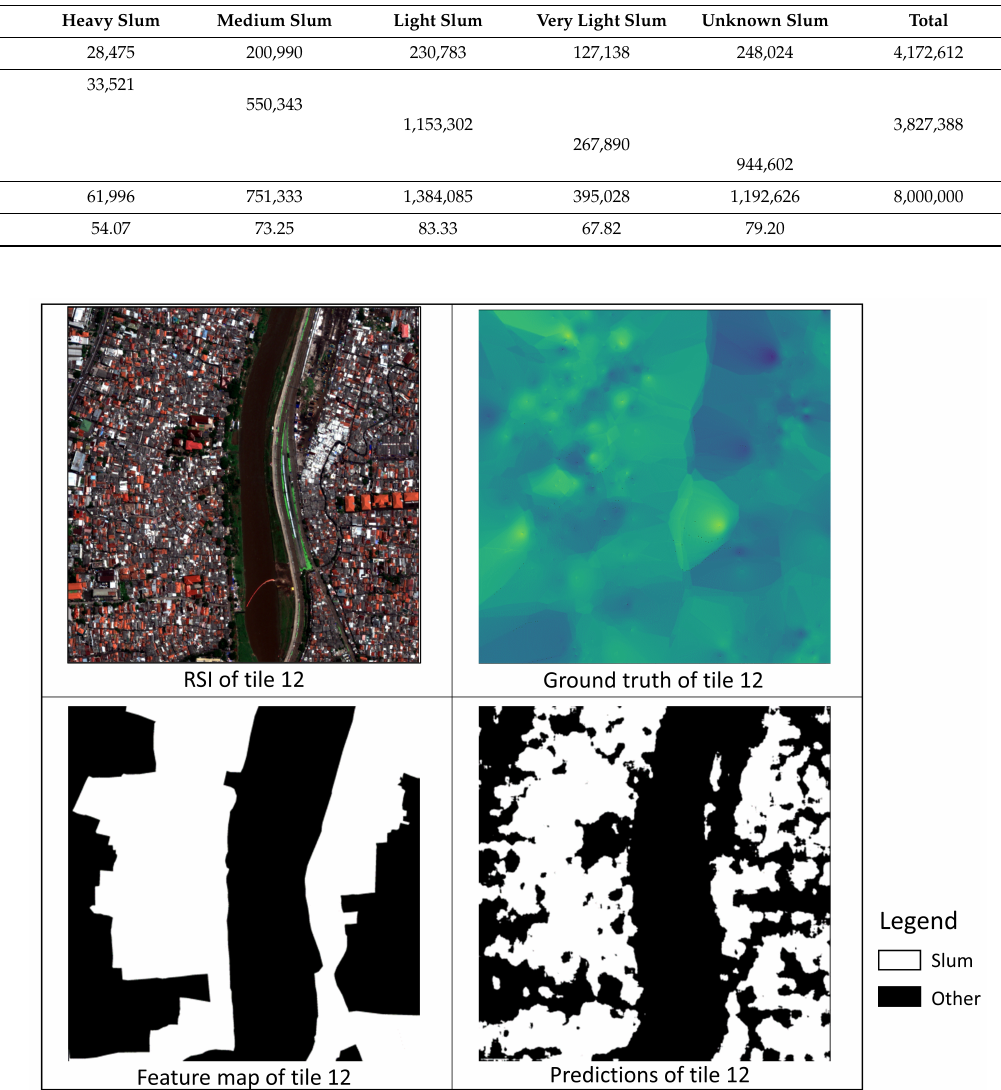
Figure 10. Outcome generated for tile-12 using Modified FCN-DK6_2,white color represents slum areas and black shows other areas